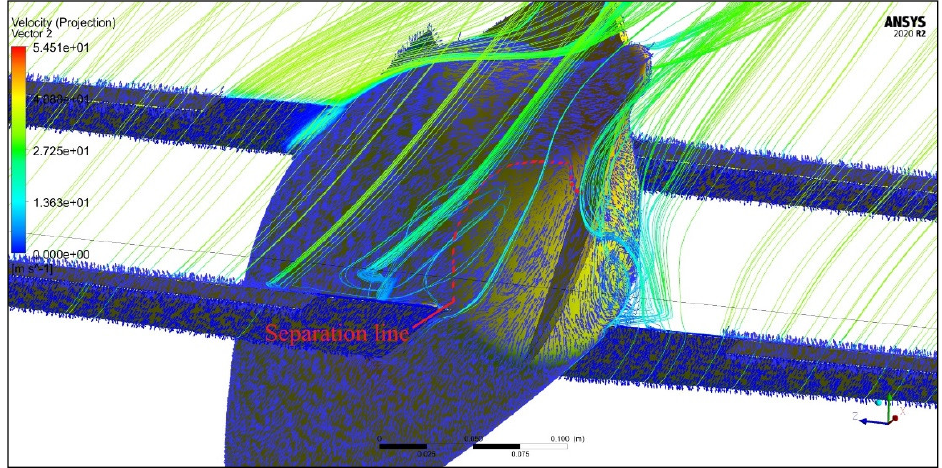
Figure 17. Flow field near the fuselage aft cone.